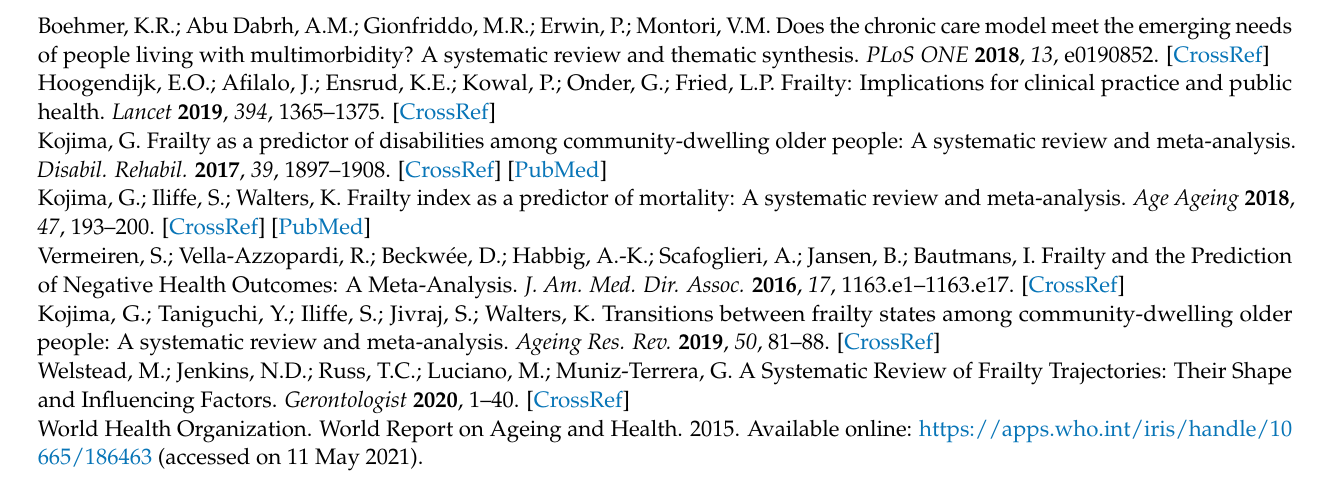
Table A1. Proposal for care objectives and interventions for each six profiles identified.